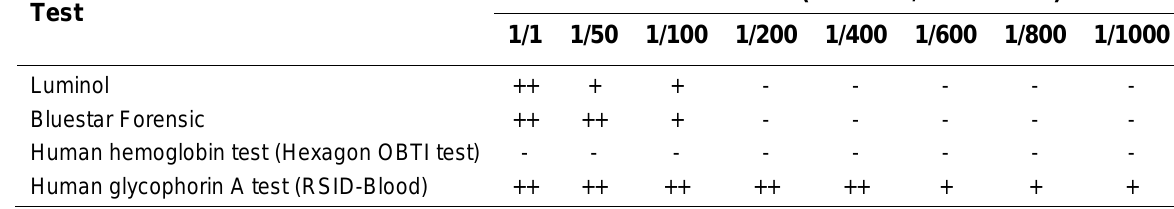
Results of the Luminol, Bluestar Forensic, Human Hemoglobin, and Human Glycophorin A Tests on Bloodstains Prepared with Different Dilutions of Blood and Washed with Sodium